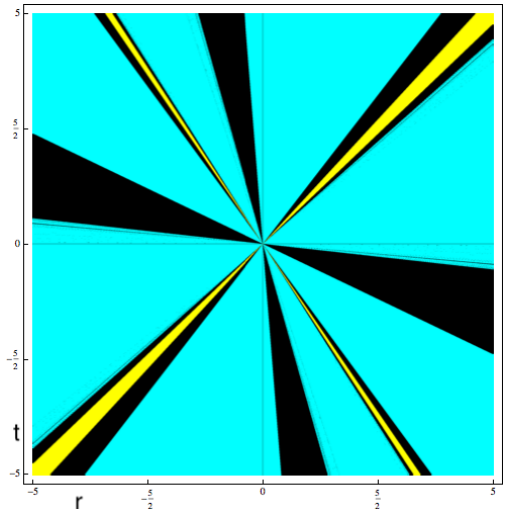
Figure 3. Parameter plane associated to the free critical point cr 2 ( r , t ) .